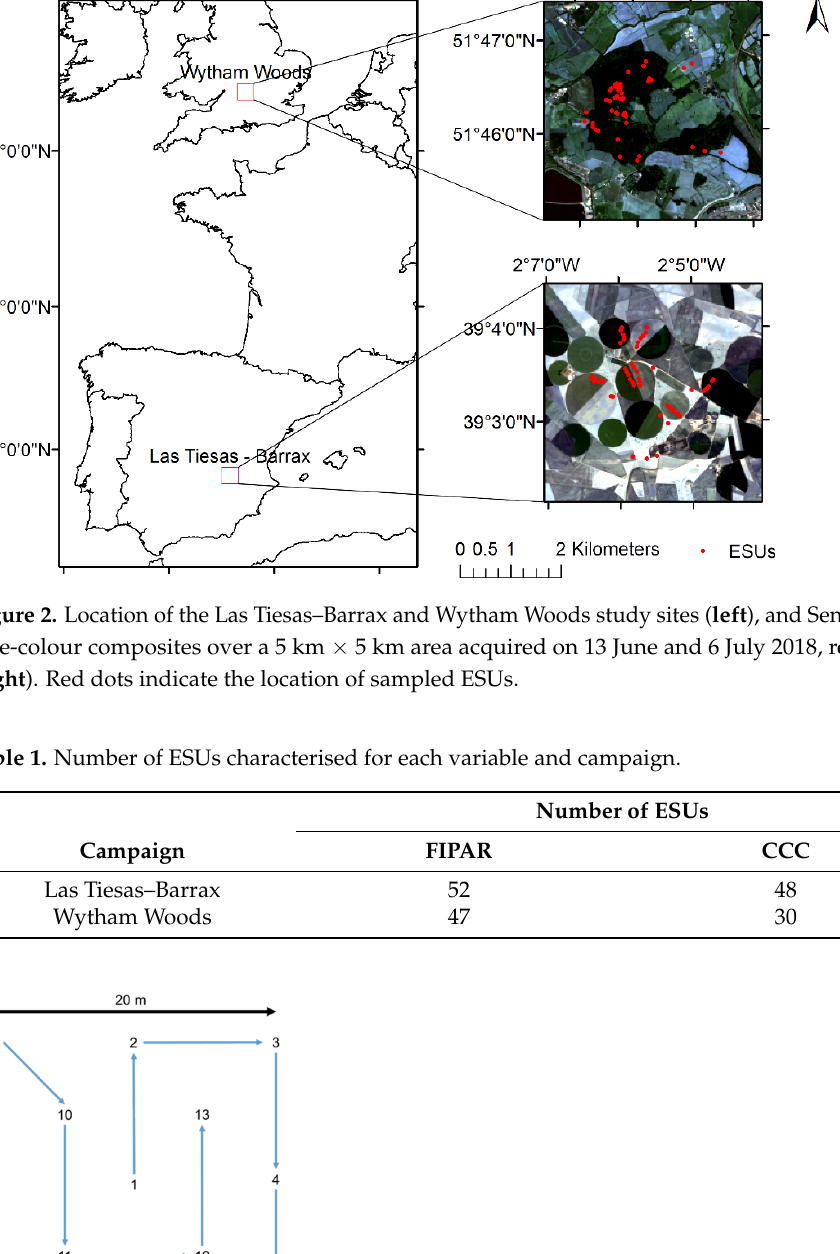
Table 1. Number of ESUs characterised for each variable and campaign.